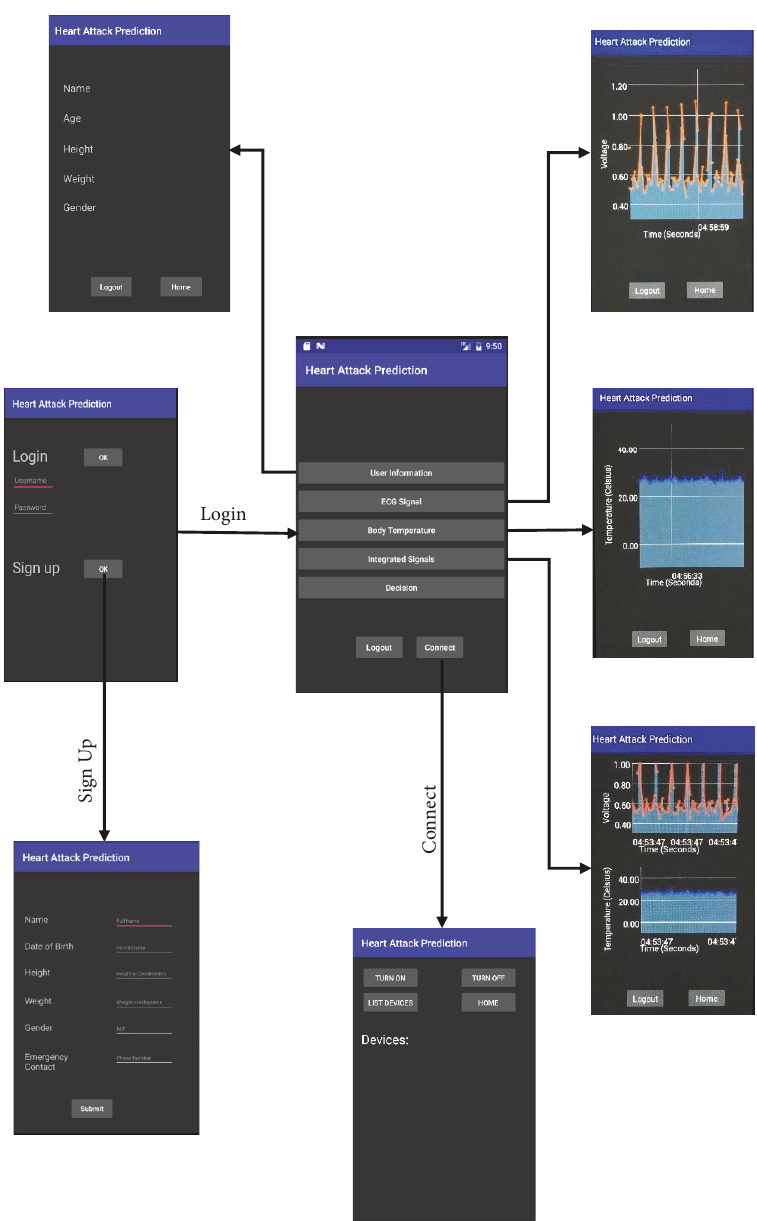
Figure 6: Smartphone user interface for data collection and for real-time